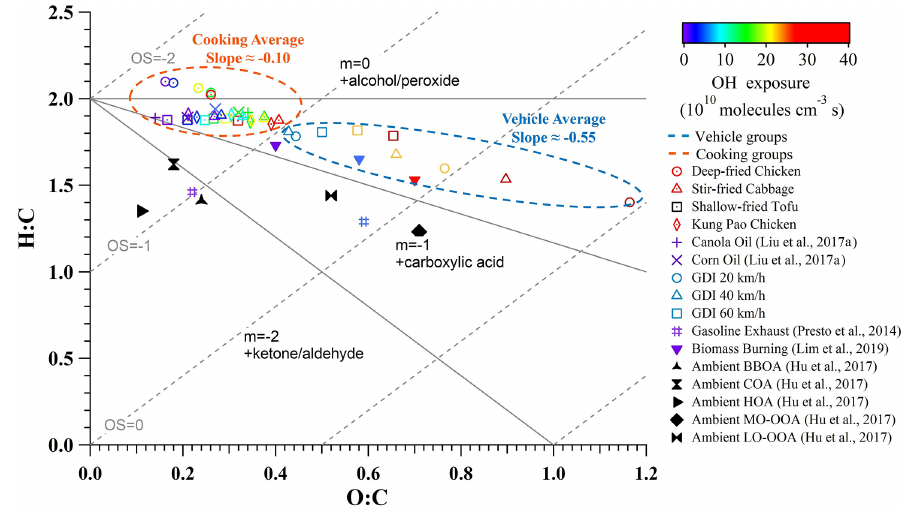
Figure 4. Van Krevelen diagram of OAs from various sources. O : C and H : C are determined by an HR-ToF-AMS. The average data at each gradient are shown in the figure.